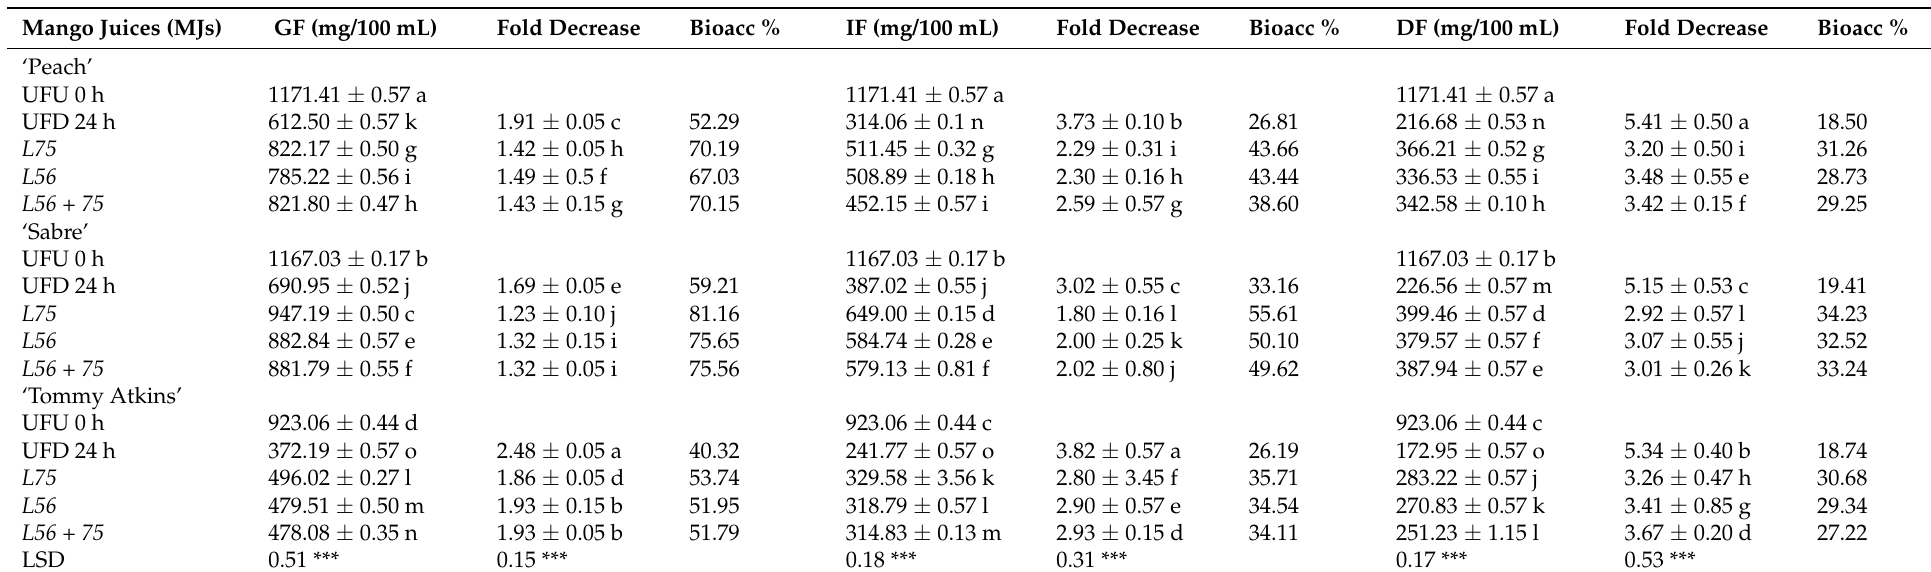
Table 1. TPC of MJs from different cultivars fermented by LAB after in vitro GI digestion. Mango Juices